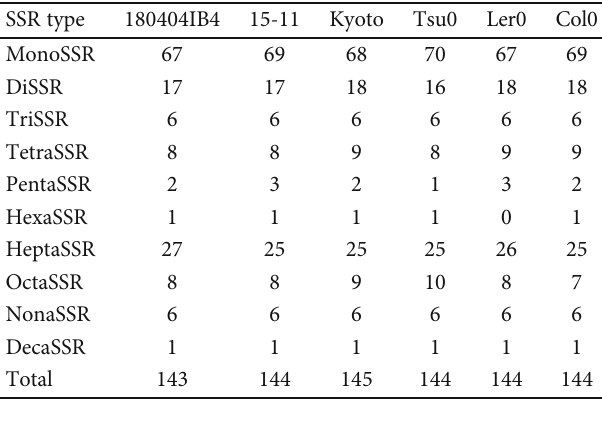
Table 4: Number of SSRs and extendedSSRs along with SSR types and its origin.